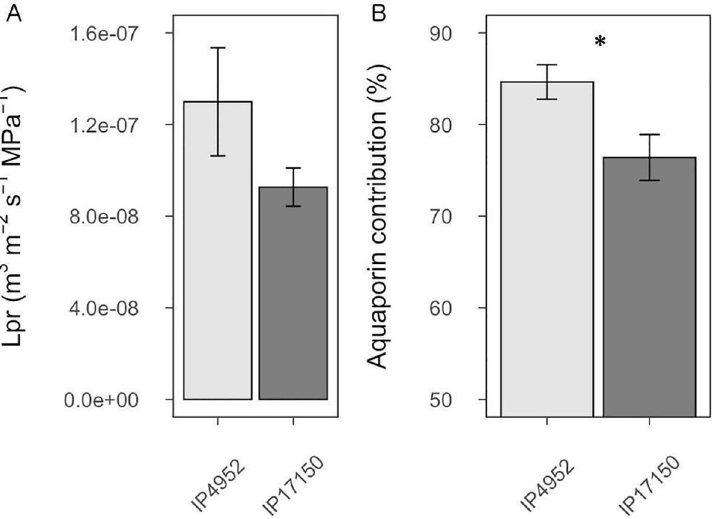
Fig 1. Root hydraulic conductivity and aquaporin contribution in roots of IP4952 and IP17150. Root hydraulic conductivity (Lpr) was measured in plants grown in hydroponic conditions between 9AM to 12PM with or without 2mM azide. (A) Lpr values were measured without azide. (B) Aquaporin contribution to Lpr shown as relative difference between Lpr of azide treated and non-azide treated plants. Bars represent mean values ± se of n = 10–15 plants. � : p <